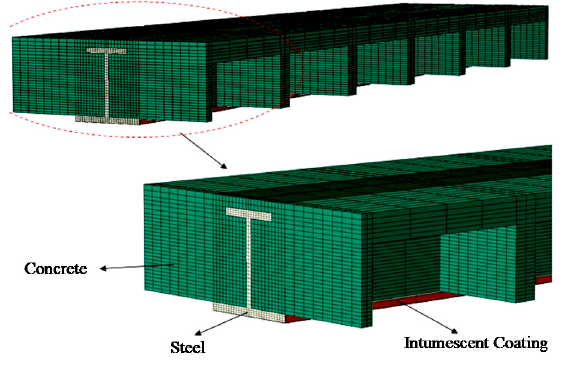
Figure 5. Slim floor protected with an intumescent coating .